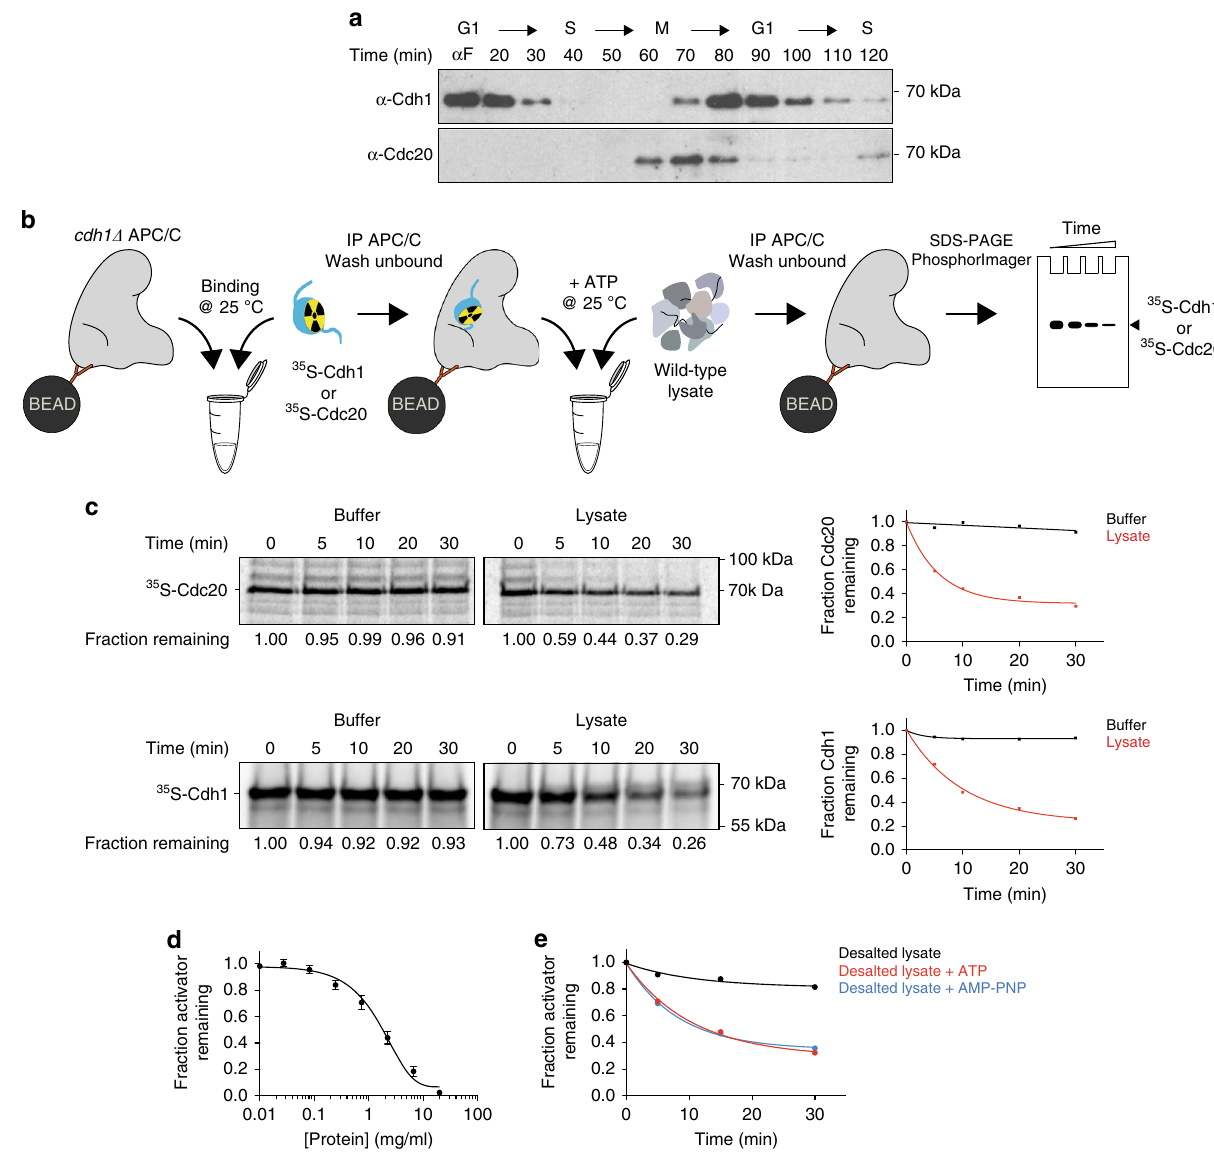
Fig. 1 A biochemical activity in yeast cell lysates dissociates activators from the APC/C. a Cells expressing TAP-tagged Cdc16 were arrested at G1 with 1 μ g/ml α -factor for 3 h and released into YPD. APC/C was immunoprecipitated at the indicated time points and western blotted for Cdh1 (upper) and Cdc20 (lower). Uncroppped western blots are provided in the Source Data fi le. b This schematic illustrates our APC/C-activator-binding assay. cdh1 Δ APC/C (TAP-tagged on the Cdc16 subunit) was immunopuri fi ed on magnetic beads and incubated with 35 S-Cdc20 or 35 S-Cdh1 produced by translation in vitro. After removing unbound activators by washing, buffer or yeast lysate (2.5 mg/ml protein concentration) was added in the presence of 5 mM ATP. At various times, APC/C was pulled down from the reaction mix and the amount of bound activator determined by SDS – PAGE and PhosphorImager analysis. Due to the extreme dilution of APC/C-activator complexes on the beads, rebinding of dissociated activator is expected to be negligible under these conditions. c As described in panel b , we measured dissociation of radiolabeled Cdc20 (top) or Cdh1 (bottom) from immobilized APC/C over the indicated time course (at 25 °C). Buffer control contains lysis buffer and 5 mM ATP. Fraction remaining was measured by calculating the ratio of activator signal at indicated time points to zero time point signal. Results were plotted and fi tted to an exponential one phase decay equation in GraphPad Prism. Similar results were observed in several independent experiments. Source data are provided in the Source Data fi le. d Cdh1 dissociation reactions were performed as in panel c in the presence of serially diluted yeast lysate, supplemented with 5 mM ATP. Remaining activator after 45 min is plotted as a function of protein concentration. Data indicate means (±SEM) from three independent experiments. Source data are provided in the Source Data fi le. e Yeast lysates were subjected to gel fi ltration in lysis buffer to remove molecules smaller than ~5 kDa. Desalted lysates were supplemented with buffer (black), 5 mM ATP (red), or 5 mM AMP-PNP (blue) prior to the Cdh1 dissociation reaction. These results are representative of multiple experiments. Source data are provided in the Source Data fi